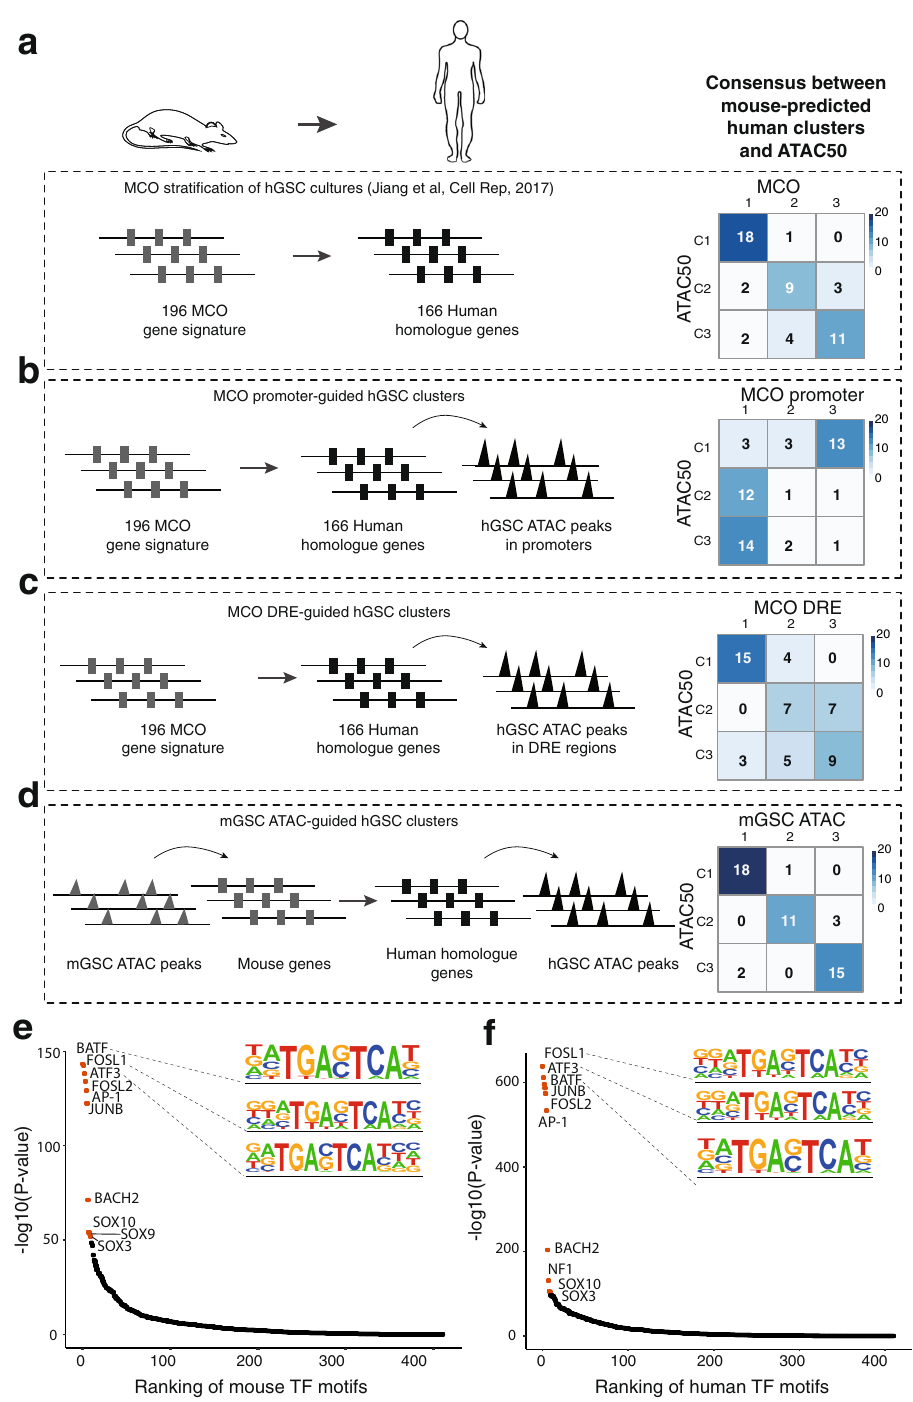
Fig. 7 Cross-species analysis reveal conservation between mouse and human GSC chromatin accessibility. a – d Analyses of mouse GSC-guided clustering of hGSC cultures and their overlap with ATAC50 clusters. a Overlap with MCO gene expression classi fi cation 22 . Schematic fi gures were produced by the authors. b Overlap with clusters produced by hGSC ATAC data at MCO gene promoters. c Overlap with clusters produced by hGSC ATAC data at MCO DRE regions. d Overlap with clusters produced by converting mGSC cluster-unique ATAC data to hGSC ATAC data through peaks-to-genes and genes-to-peaks conversions. e Ranking of enriched TF motifs in mGSC cluster-speci fi c ATAC peaks. Red circles indicate top-10 signi fi cant motifs. f Ranking of enriched TF motifs in the hGSC ATAC peaks obtained in ( d ). Red circles indicate top-10 signi fi cant motifs. Source data are provided as a Source Data fi le for Fig. 7a –